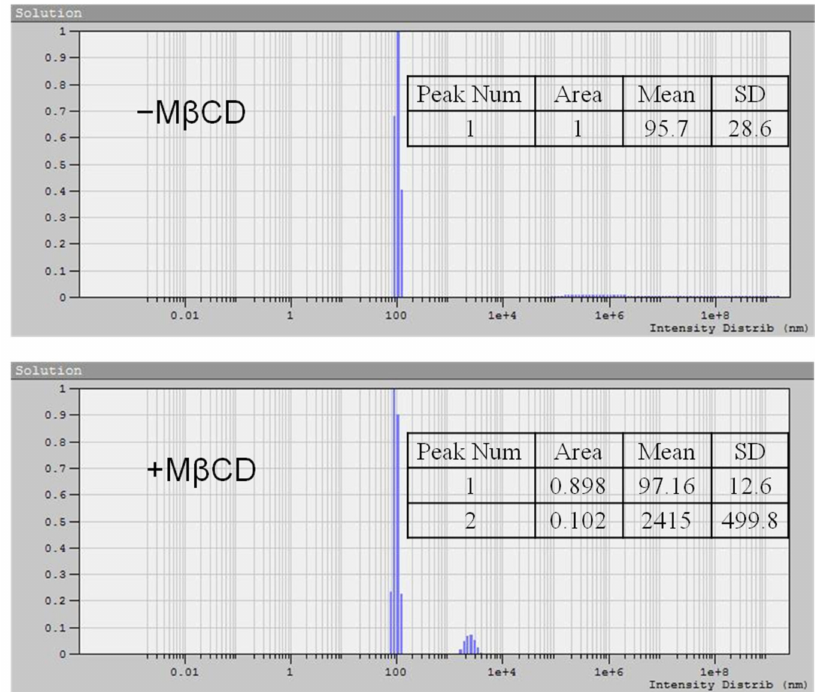
Figure 3. Distributions of particle sizes obtained by Dynamic Light Scattering in the absence (top) or presence (bottom) of 10 mM M β CD in vesicular suspension. Particle radiuses are represented by means ±